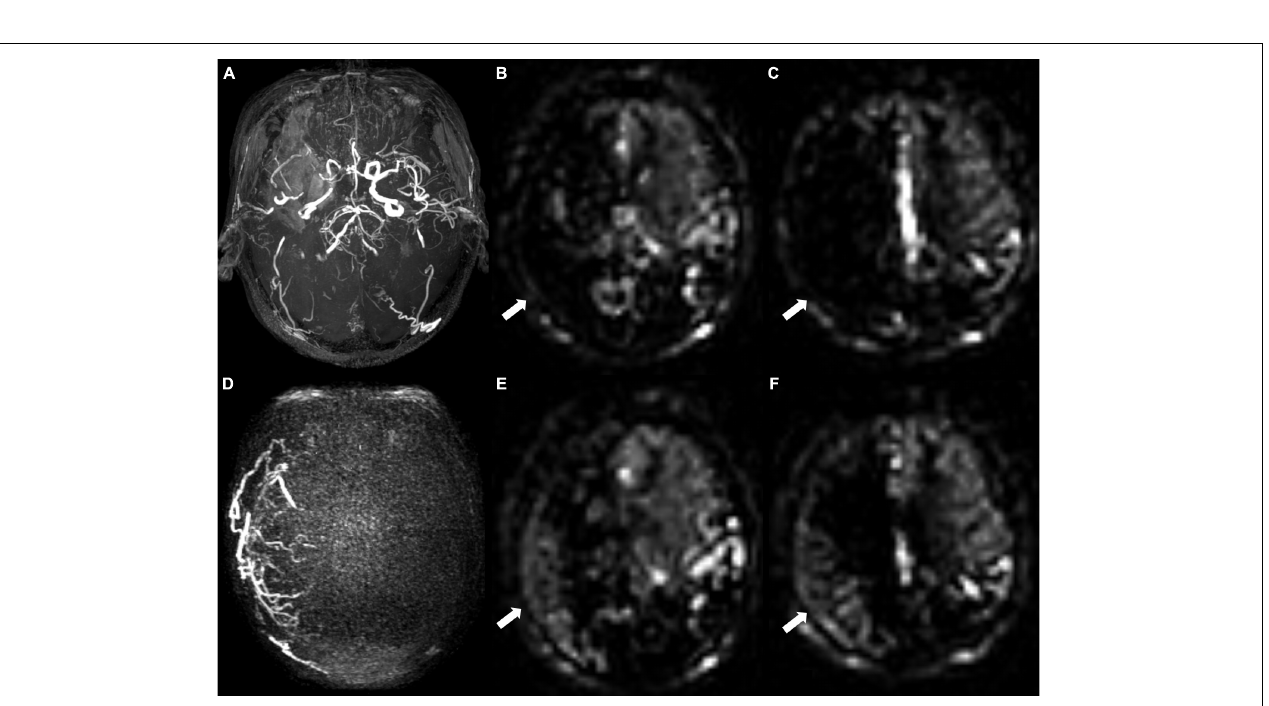
FIGURE 4 | A 68-year-old male patient with unilateral moyamoya angiopathy. (A) Presurgical MR angiography image. Right middle cerebral artery was occluded. (B,C) Two-slice ASL images of ASPECT regions, and cerebral perfusion was significantly reduced. Preoperative collateral score was almost 0 in (B) and 1 in (C) . (D) Postoperative super-selective 4D MRA images of external carotid artery. Postsurgical collaterals were defined as good (2 scores according to Matsushima standard). (E,F) ASL images at same level as (B,C) . Postoperative collateral scores increased (white arrows), which were 6 in (E) and 6 in (F) .